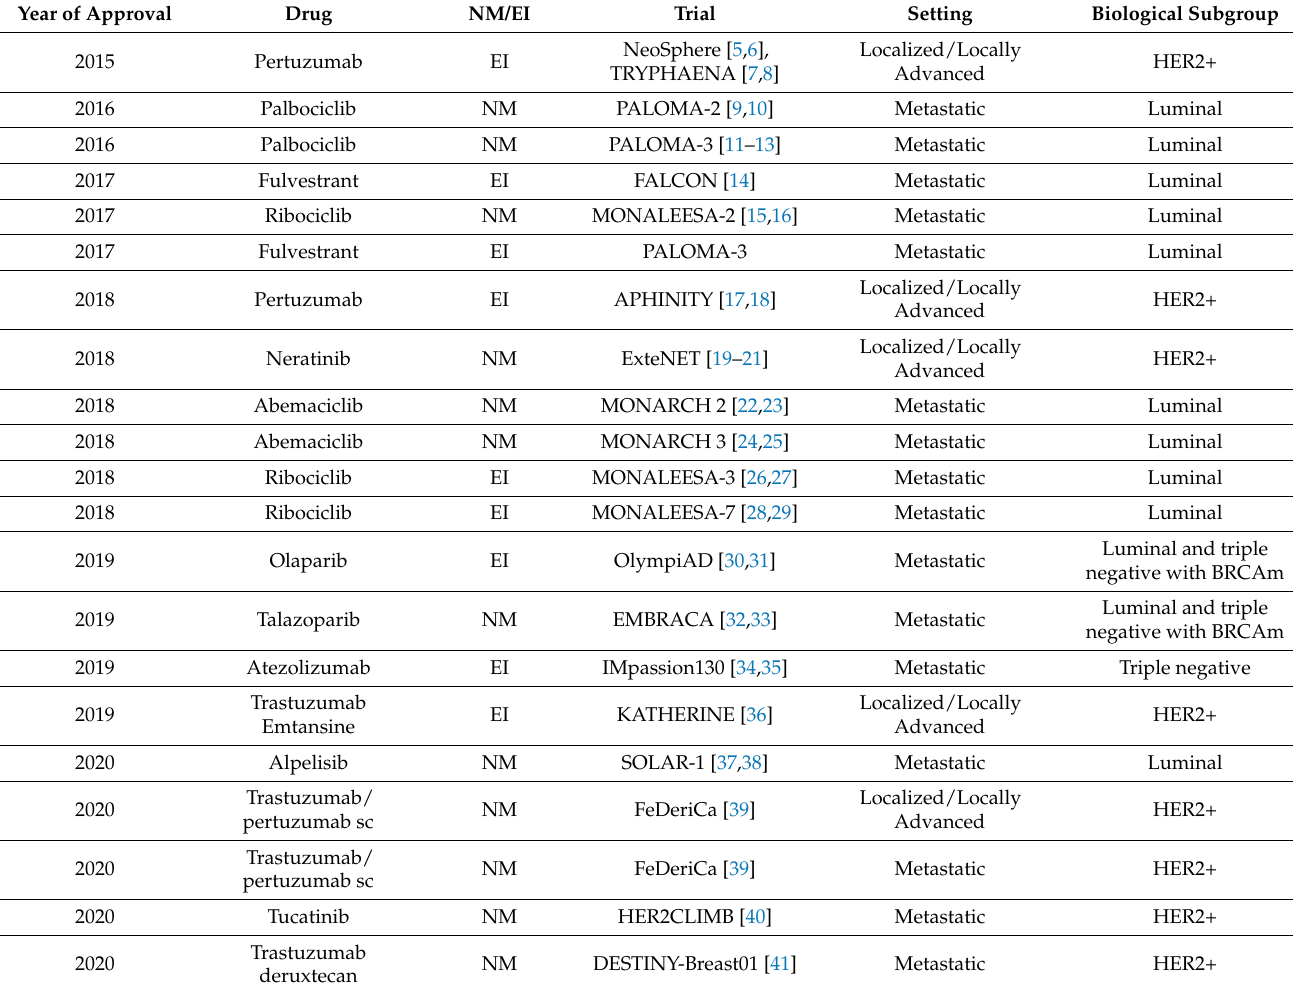
Table 1. New indications of breast cancer drugs issued by EMA between January 2015 and June 2021 and pivotal clinical